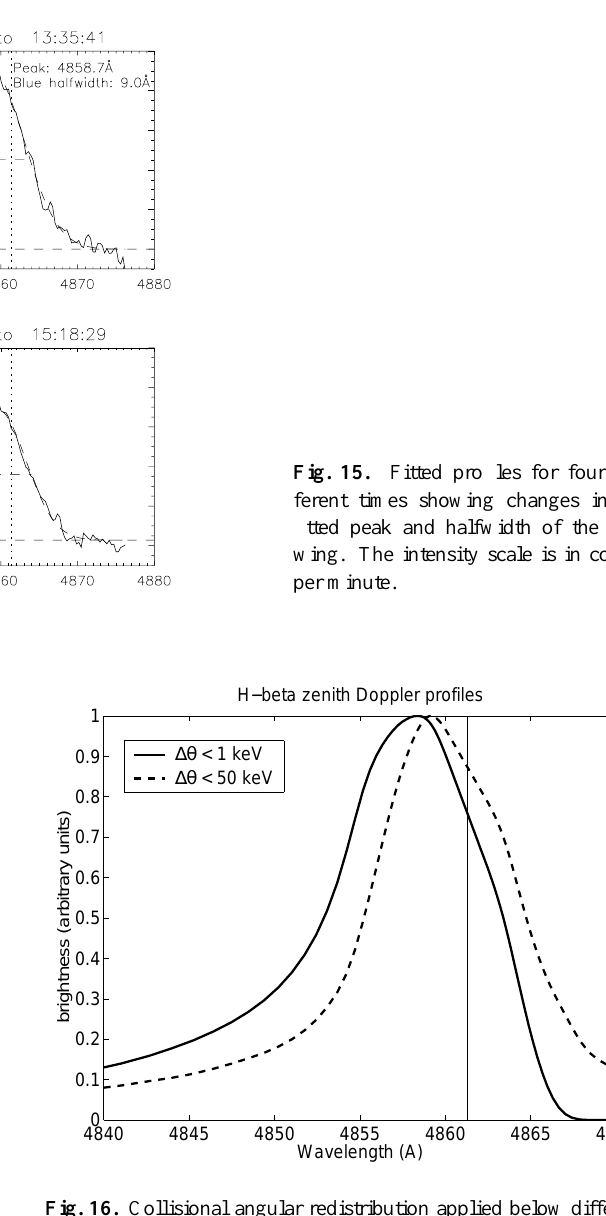
Fig. 16. Collisional angular redistribution applied below different energy